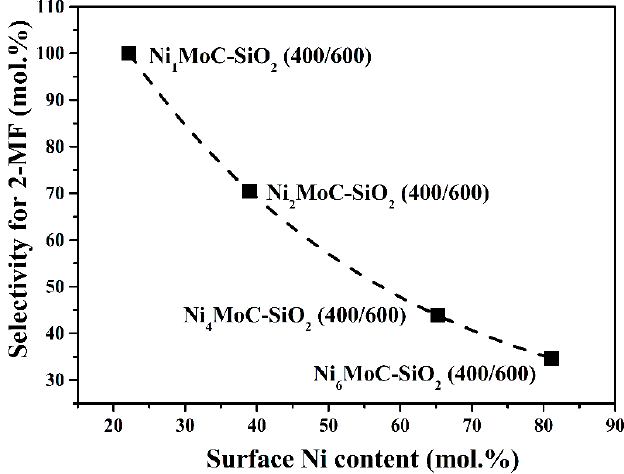
Figure 14. Relation of the selectivity for 2-MF formation from FA with the surface nickel content.